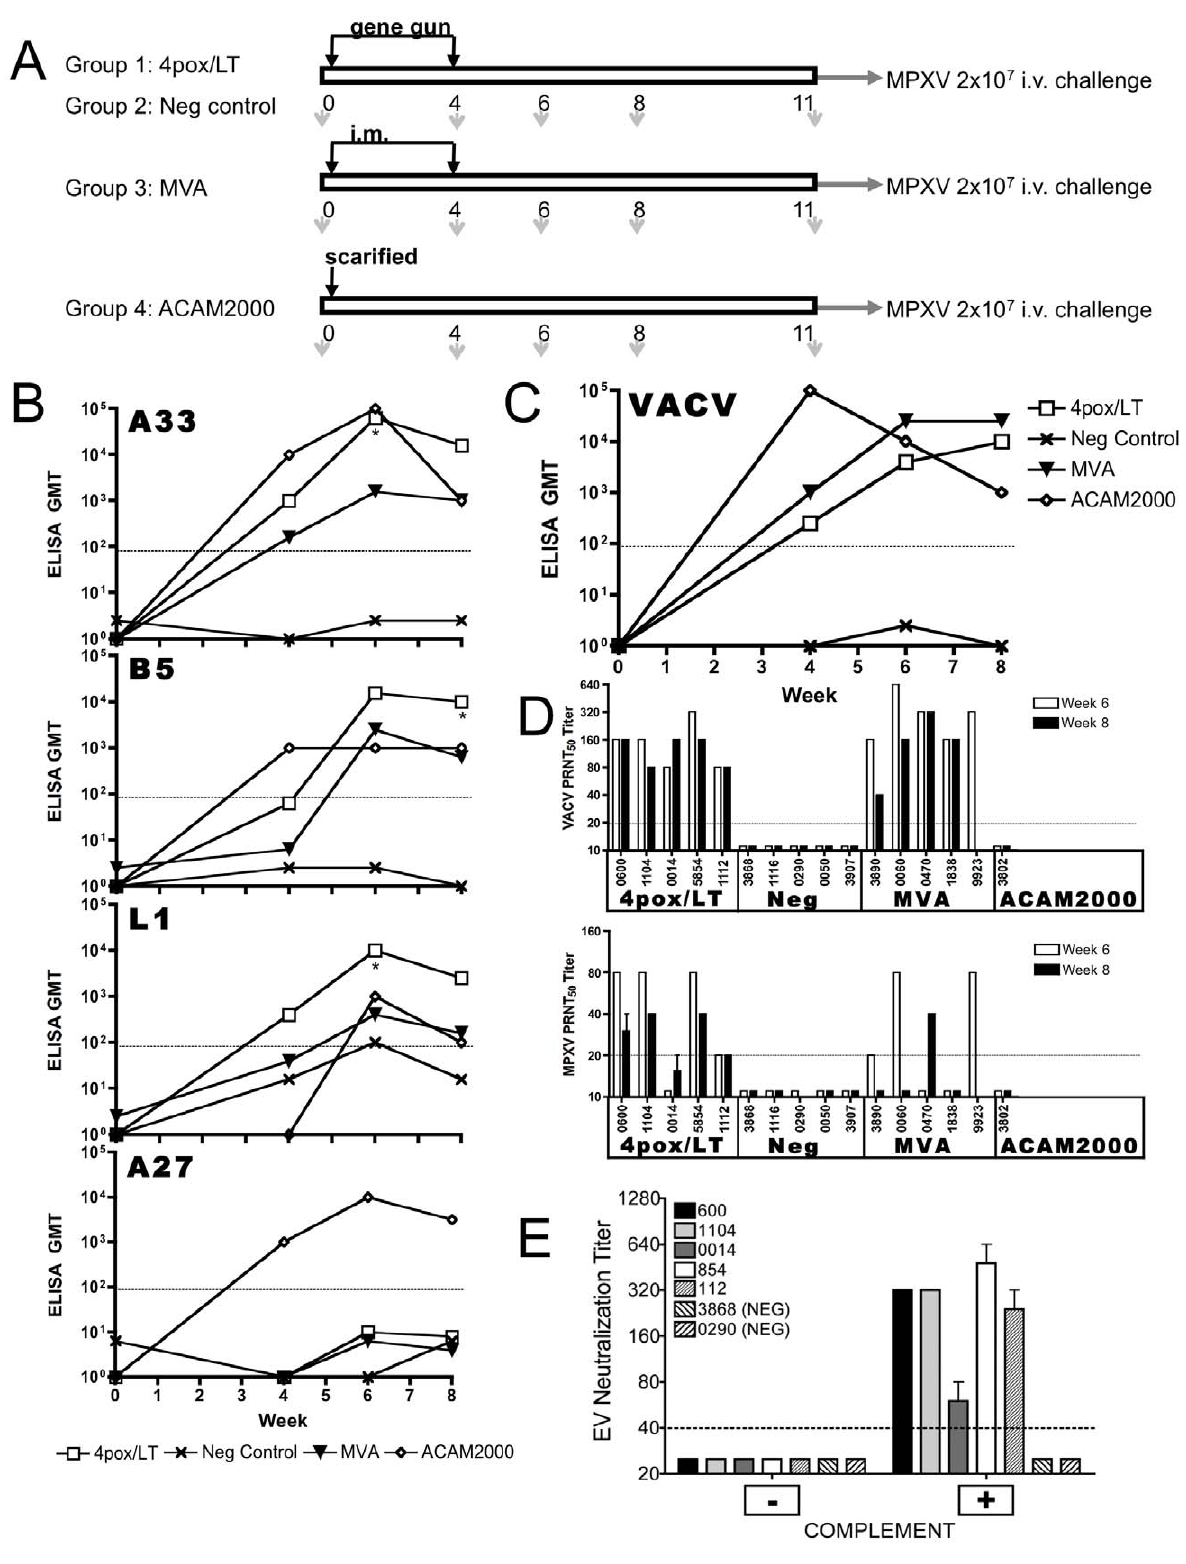
Figure 3. Vaccination of NHP with 4pox, MVA and ACAM2000. A . Schematic showing the vaccination protocol. NHPs were vaccinated with the 4pox/LT vaccine or negative control DNA by the ND10 device twice at 4-week intervals. Another group of NHP was intramuscularly vaccinated with MVA (ACAM3000) 1 6 10 8 pfu/dose twice at a 4-week interval. One NHP was vaccinated with a single dose of ACAM2000 and served as a positive control. The down arrows indicate bleed dates. B . Sera from individually vaccinated NHPs were collected at week 0, 4, 6 and 8 and level of antigen- specific antibodies was examined by protein-ELISA as in Figure 1, with the exception that a monkey secondary was used (1:2000). Data were plotted